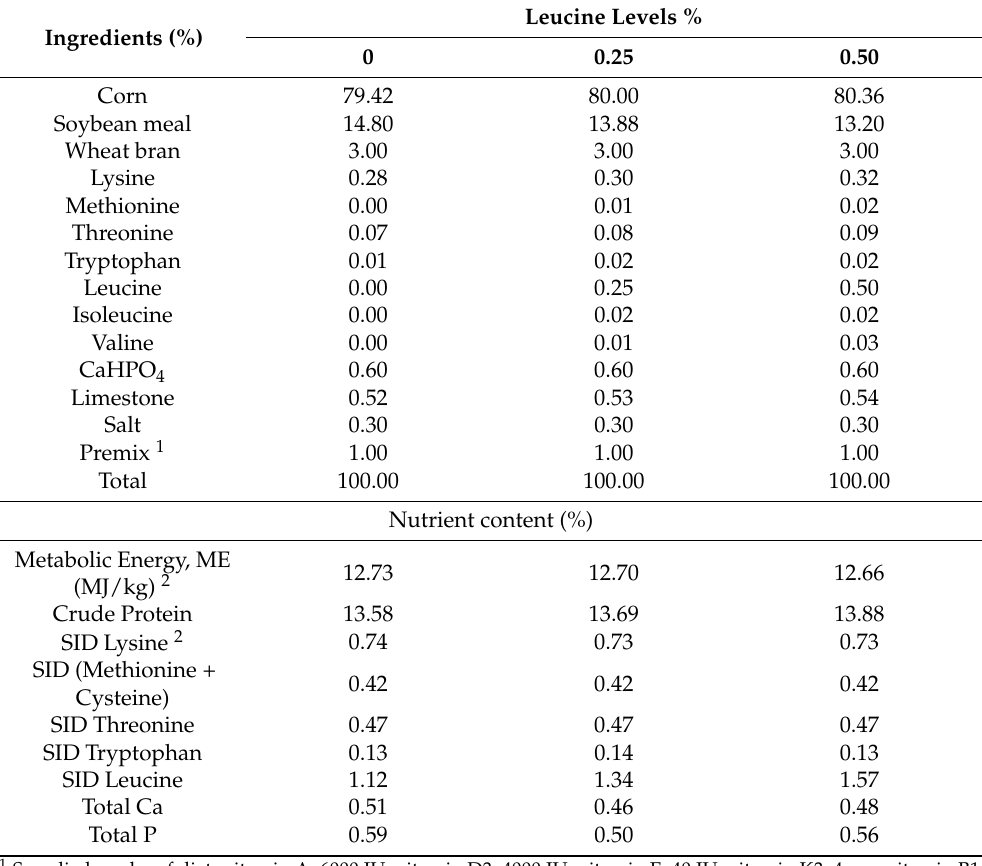
Table 1. Ingredients and nutritional composition of basic diets (low protein diet).